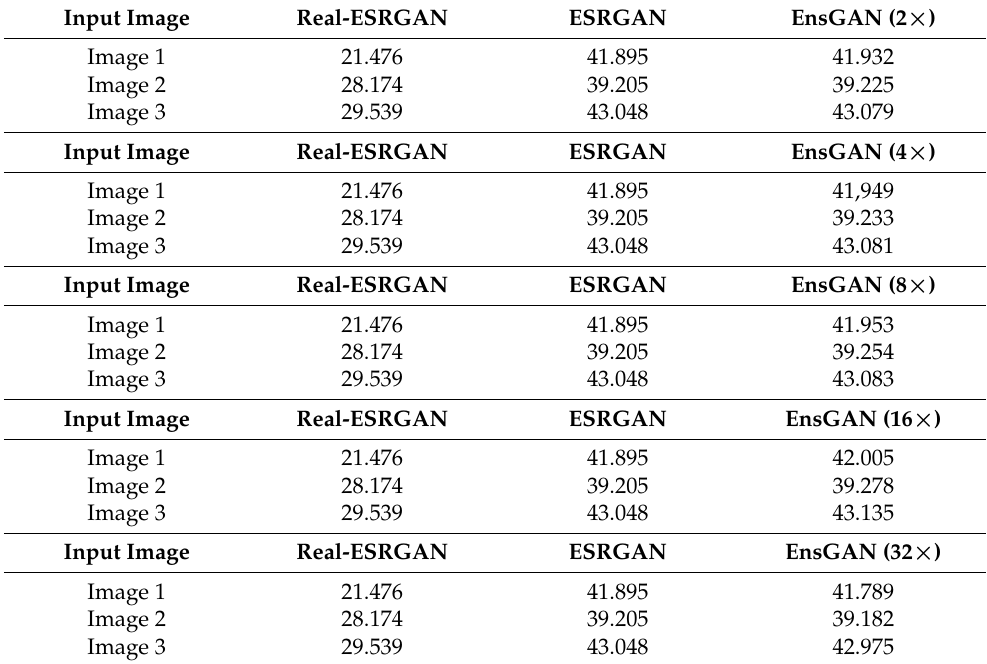
Table 1. Comparison of Real-ESRGAN, ESRGAN, and proposed EnsGAN for PSNR results on three sample images from the Severstal steel defect dataset. The defect samples in these three images are shown in Figure 8 in the following order: the top is Image 1, the middle is Image 2, and the bottom is Image 3.